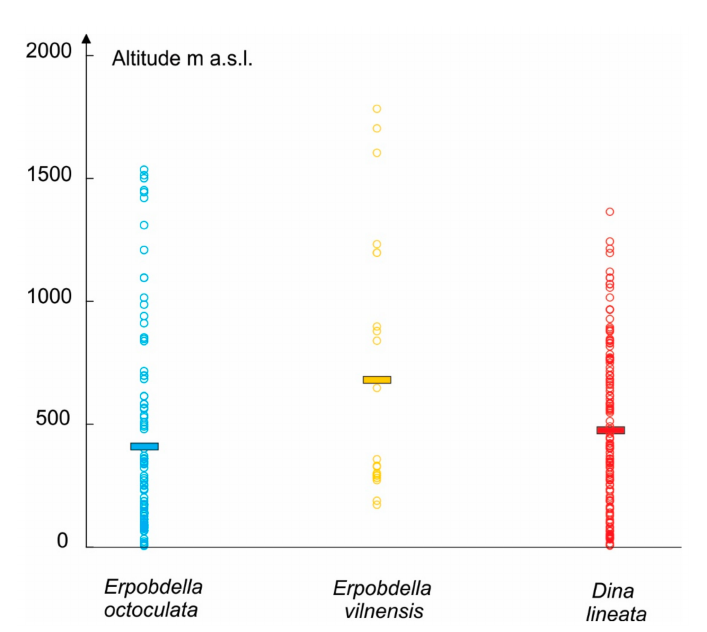
Figure 2. The distribution of the analyzed species along altitudinal gradient. Circles correspond to sampling sites. Rectangles denote mean altitude of sites inhabited by a particular